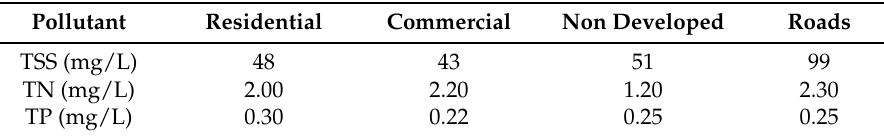
Table 2. Pollutant Event Mean Concentrations (EMCs)